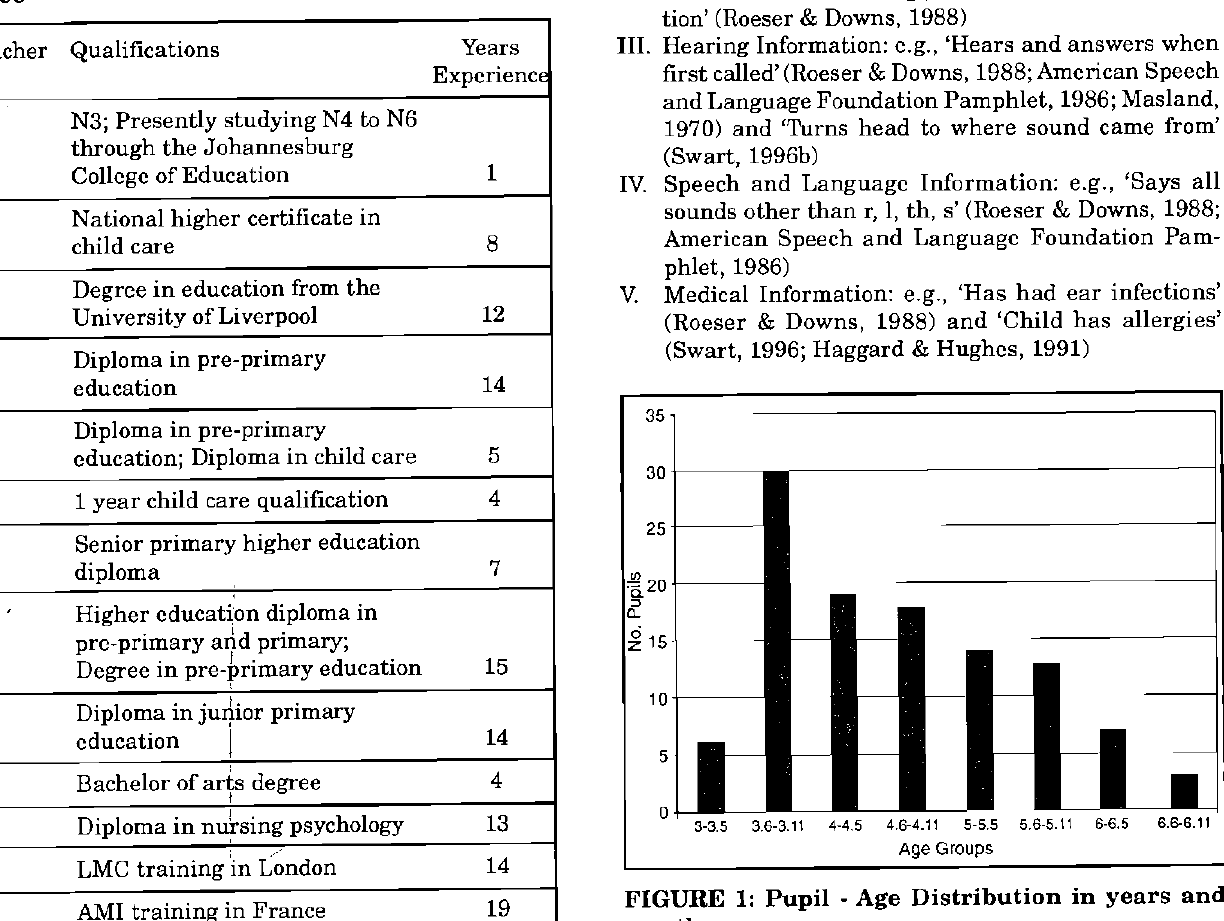
Table 1: Teacher qualifications and teaching expe- rience